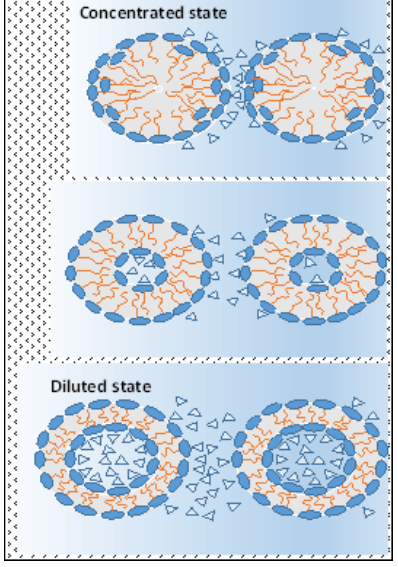
Figure 7. Schematic representation of formation of micellar, rod-like, or disc-like bilayers in depend- ence on water content in the hydrotropic system, i.e., by prevailing hydro-attraction (concentrated state) or hydro-repulsion (diluted state) among the polar part of amphiphilic interacting molecules. The symbols “ ∆ ” denote water molecule O < HH .